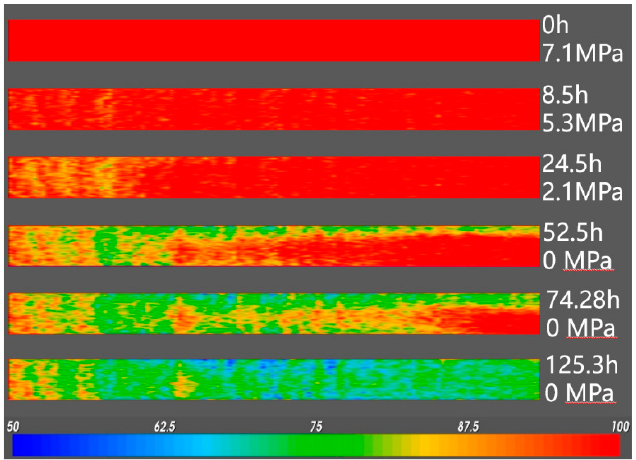
Figure 9. Oil saturation CT reconstruction images for Experiment 4.